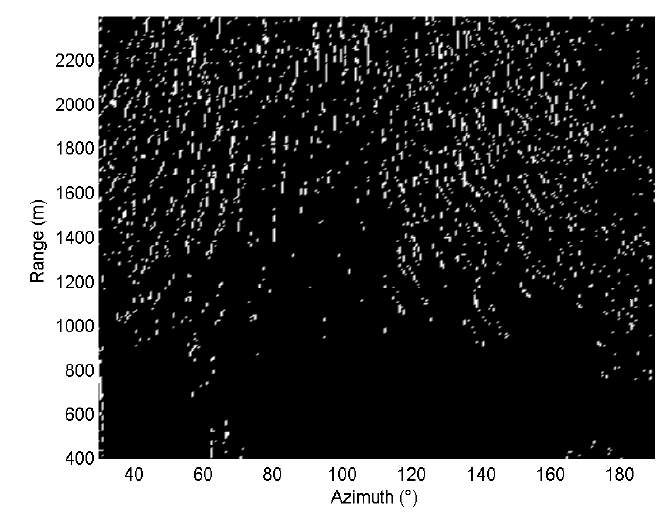
Figure 7. The edge image after thresholding and filtering out the single-point noise. The corresponding pixels of the edge image in the radar image is used to perform a histogram statistics. Then, the shadow gray-scale threshold τ S is obtained by taking a mode on the histogram. The histogram statistics and the gray-scale threshold which are respectively indicated by the pink curve and red vertical dotted line are shown in Figure 8. In addition, the histogram of the radar image is also presented. The blue curve is the overall gray-scale distribution curve of the radar image.